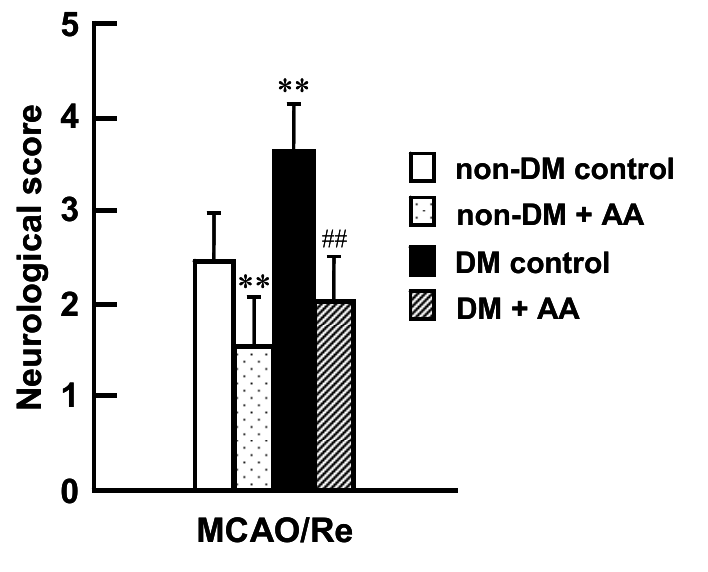
Figure 2. Effects of AA supplementation on neurological deficits induced by MCAO/Re in nondiabetic and diabetic rats. Postischemic neurological deficits were evaluated on a 5-point scale at 24 h of reperfusion after 2 h of MCAO. Data are mean ± SD of 6–7 rats per group. ** p < 0.01 compared with the nondiabetic control group. ## p < 0.01 compared with the diabetic control group. DM in the figure denotes diabetic, while non-DM denotes